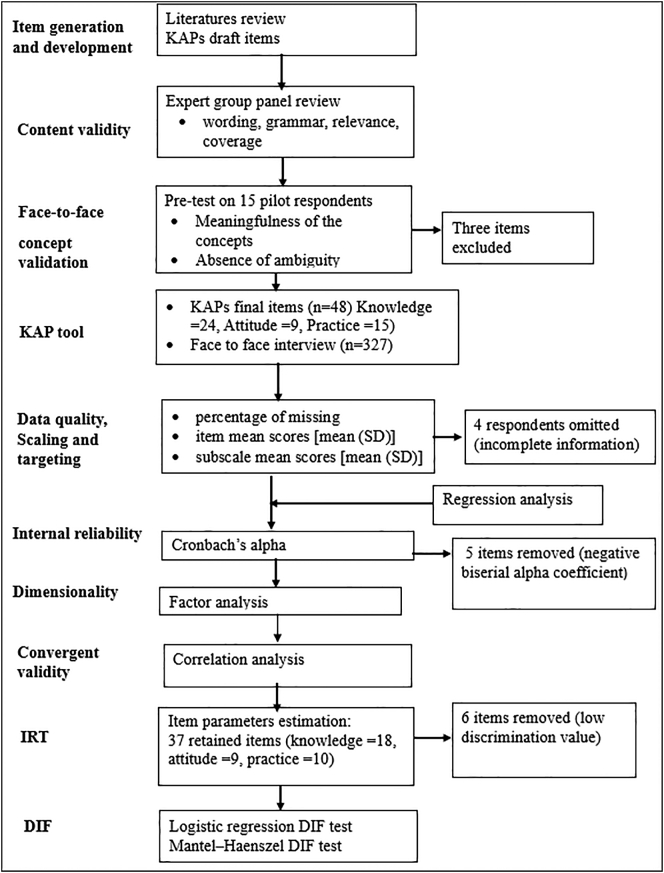
Study flowchart.